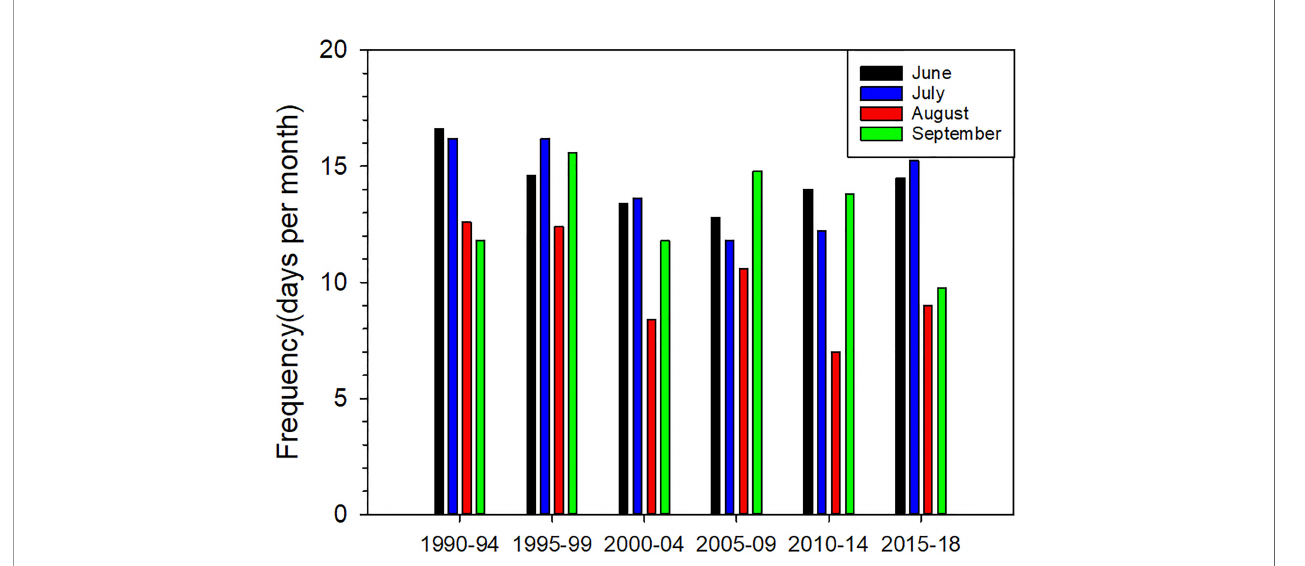
FIGURE 9 | The monthly averaged frequency of wind speeds >6 m/s based on 5-year grouping in summer during 1990-2018 at Waglan